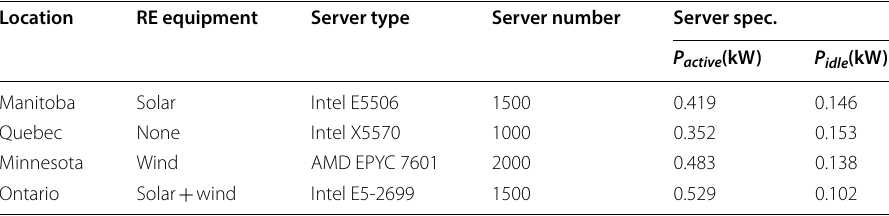
Table 5 Cloud specification